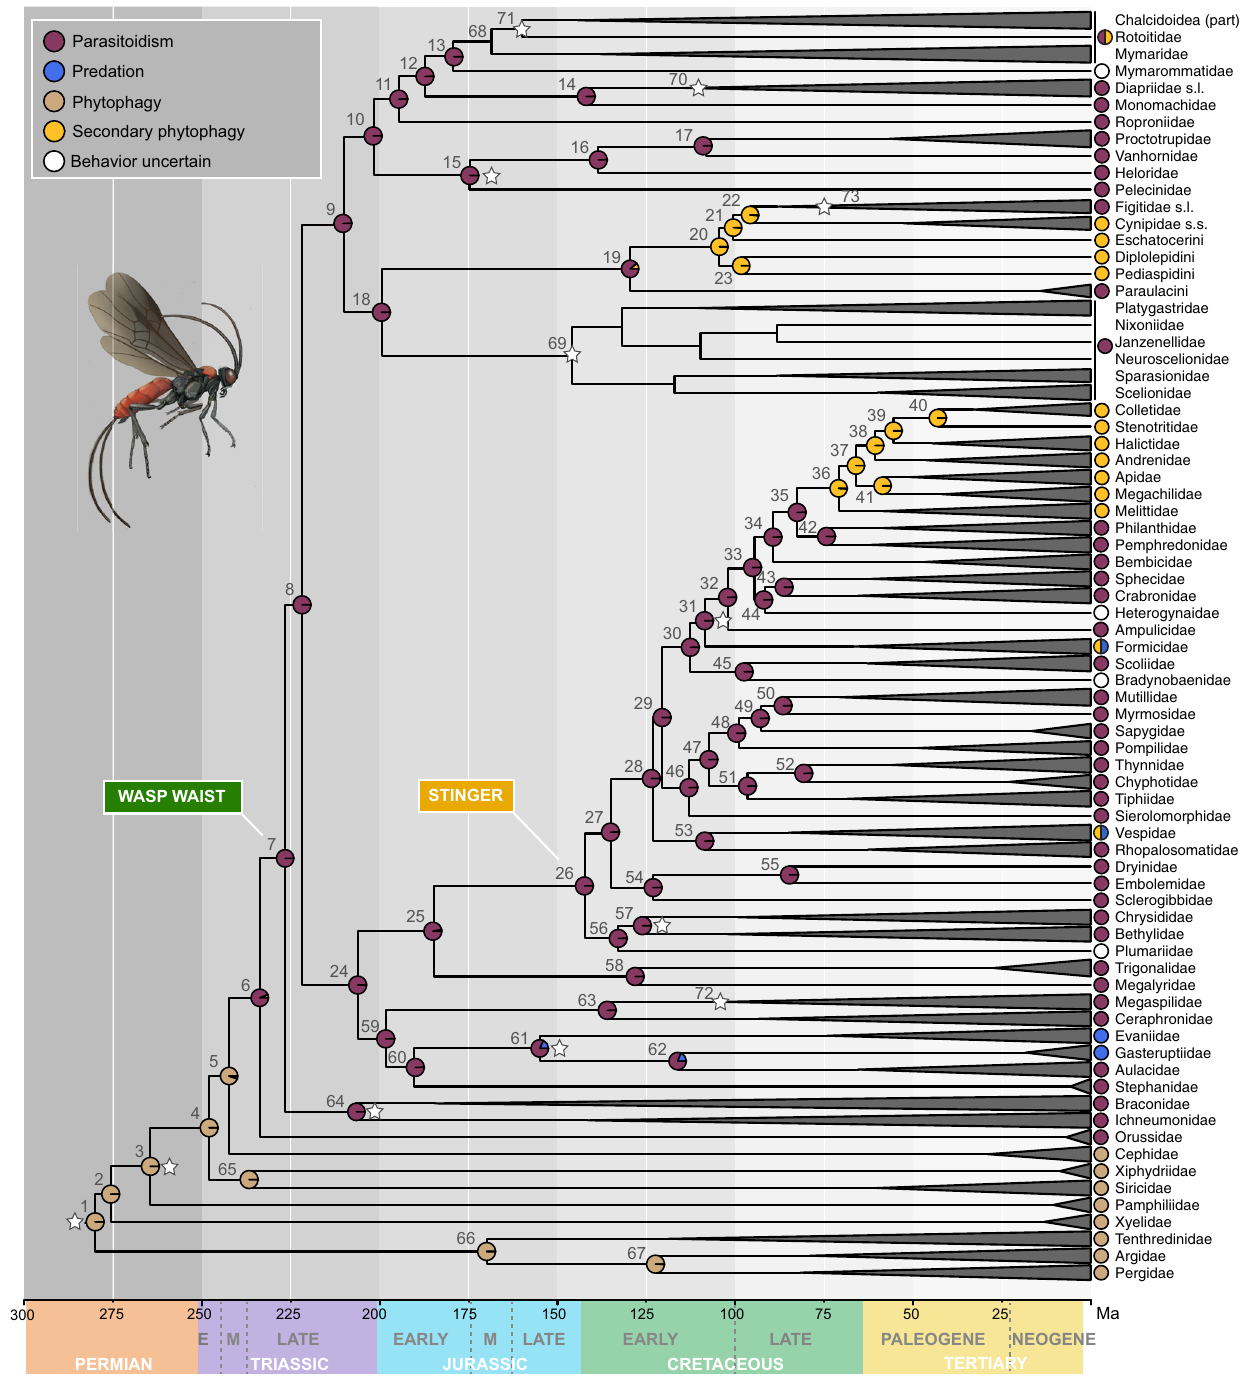
Fig. 2 | Timeline and evolution of parasitoidism in Hymenoptera. Chronogram estimated using approximate likelihood in MCMCTREE with the PAMLv4.9 package 113 from the nuc-70% matrix and topology C-1. All outgroups were pruned from the tree and alignment prior to divergence time estimation. Twelve calibra- tion points were used, which are indicated by a white star. Terminals have been collapsed down to family or clade-level post analysis. Families of Platygastroidea are shown in the chronogram, but were lumped at the superfamily level for ancestral state reconstructions; therefore, pies are absent in this clade. Ancestral state reconstructions with corHMM were estimated from topology C-1 and